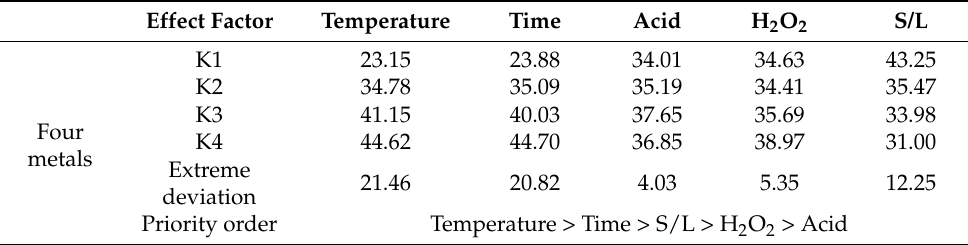
Table 8. Factor response table for four metals in malic